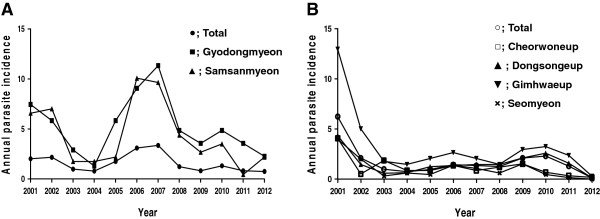
Annual parasite incidence of study areas from 2001 to 2012. A, Ganghwa county; B, Cheorwon county.